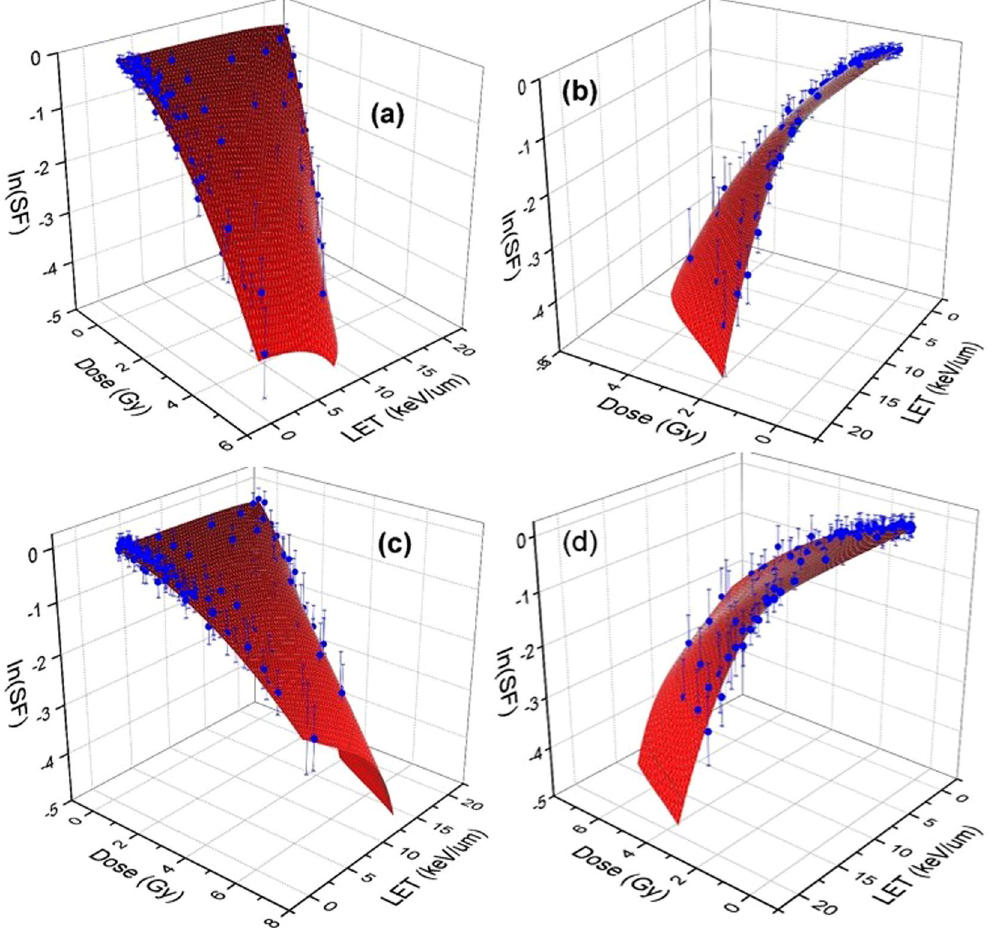
Figure 3. Experimental data of clonogenic survival fraction (SF) corresponding to H460 ( a , b ) and H1437 ( c , d ) cells are shown in blue dots with experimental error bars in logarithmic scale. The surfaces are fitted to the experimental data using global 3D optimization using a non-linear LET model as presented in the text. The left and right figures show the views from low and high